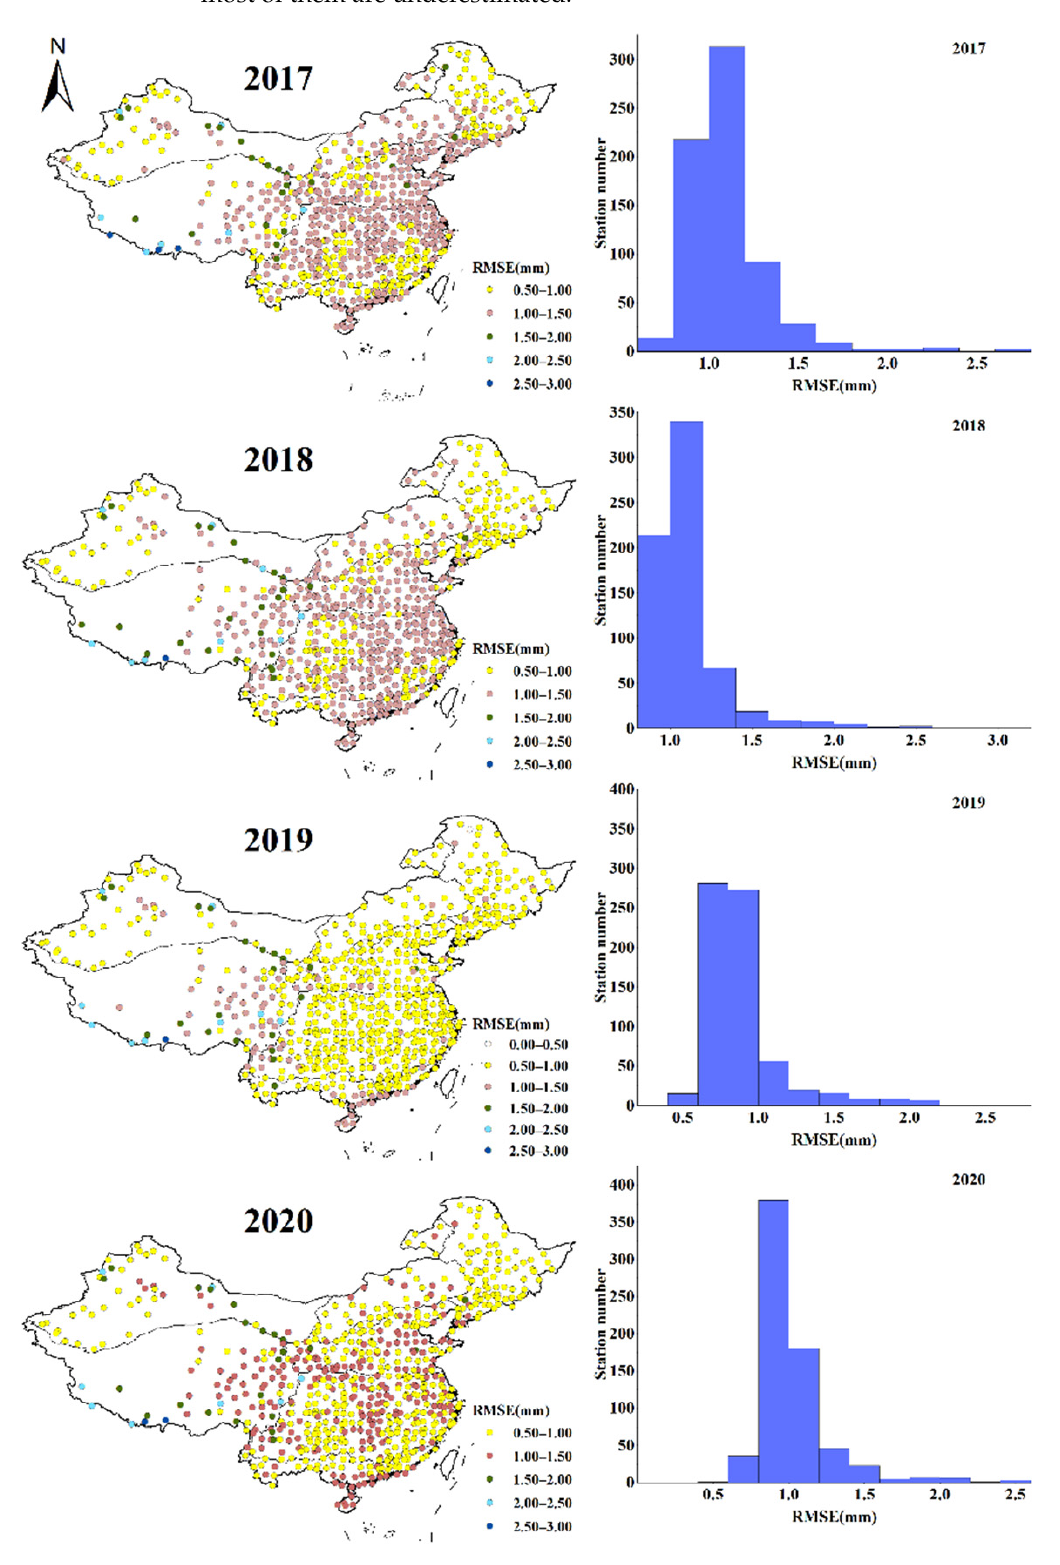
Figure 11. Annual RMSE of ET 0 calculated from CLDAS dataset.